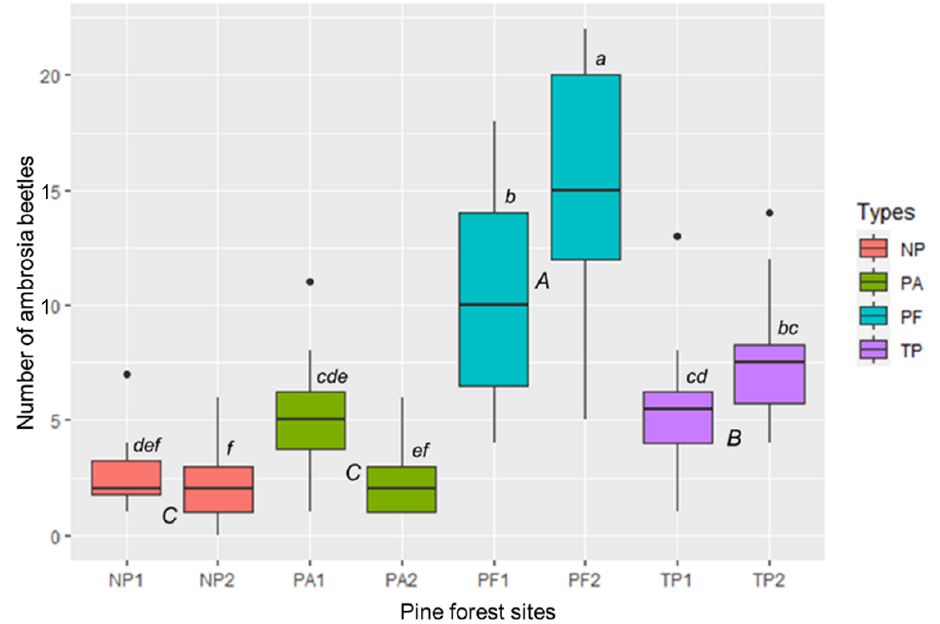
Figure 3. Difference of the ambrosia beetle’s population between the pine forest types or sites in East Java, Indonesia. PA = pine forest-based agroforestry, NP = non-tapped pine forest, PF = protected pine forest, TP = tapped-pine forest. Boxplots with different capital and small letters were significantly different between the pine forest types and sites at p < 0.05, according to Tukey HSD. Bars represent the interquartile range with the median value. Circles indicate outliers. Vertical solid lines indicate minimum and maximum values.